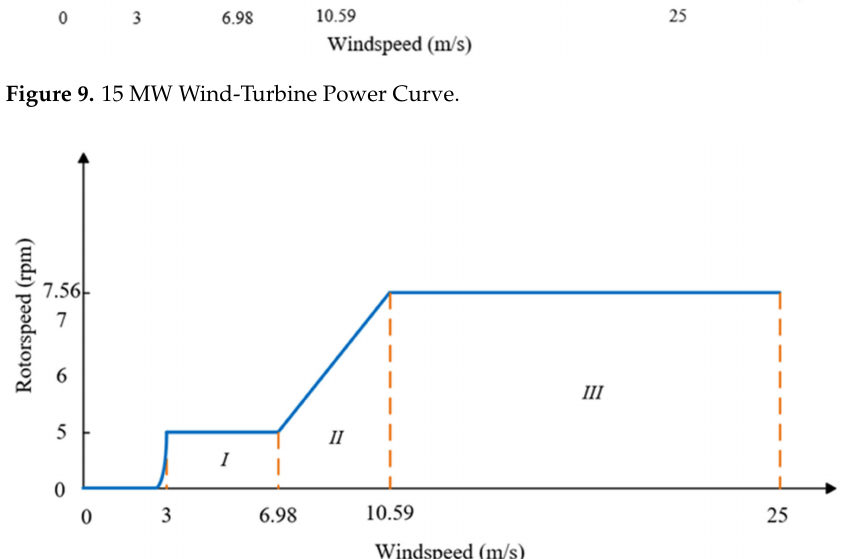
Figure 10. Relationship between Rotor Speed and Wind